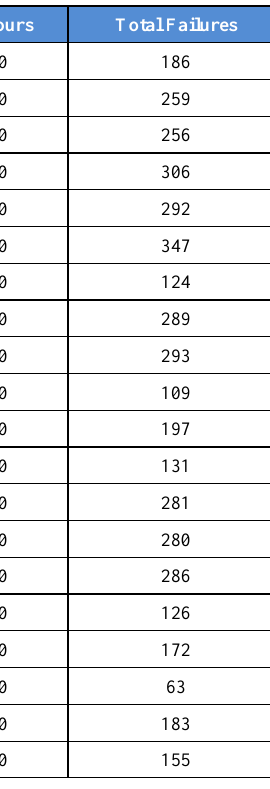
Table 1. Summary of failures data in TNE